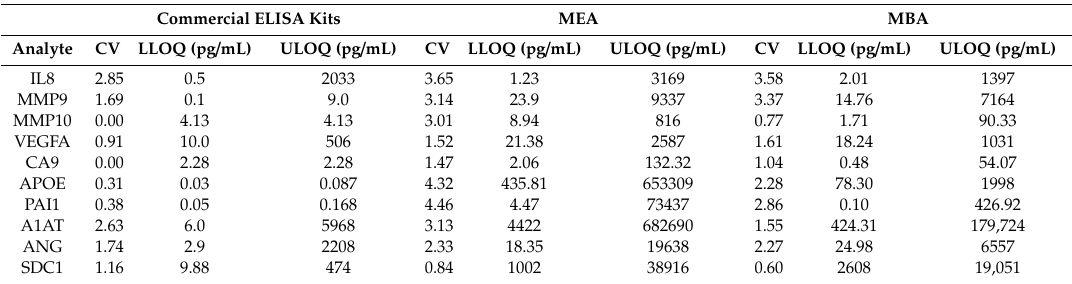
Table 1. Lower limits of quantification, upper limits of quantification, and coe ffi cient of variation between commercial ELISA kits and two multiplex array platforms for detecting 10 urine-based biomarkers associated with bladder cancer.